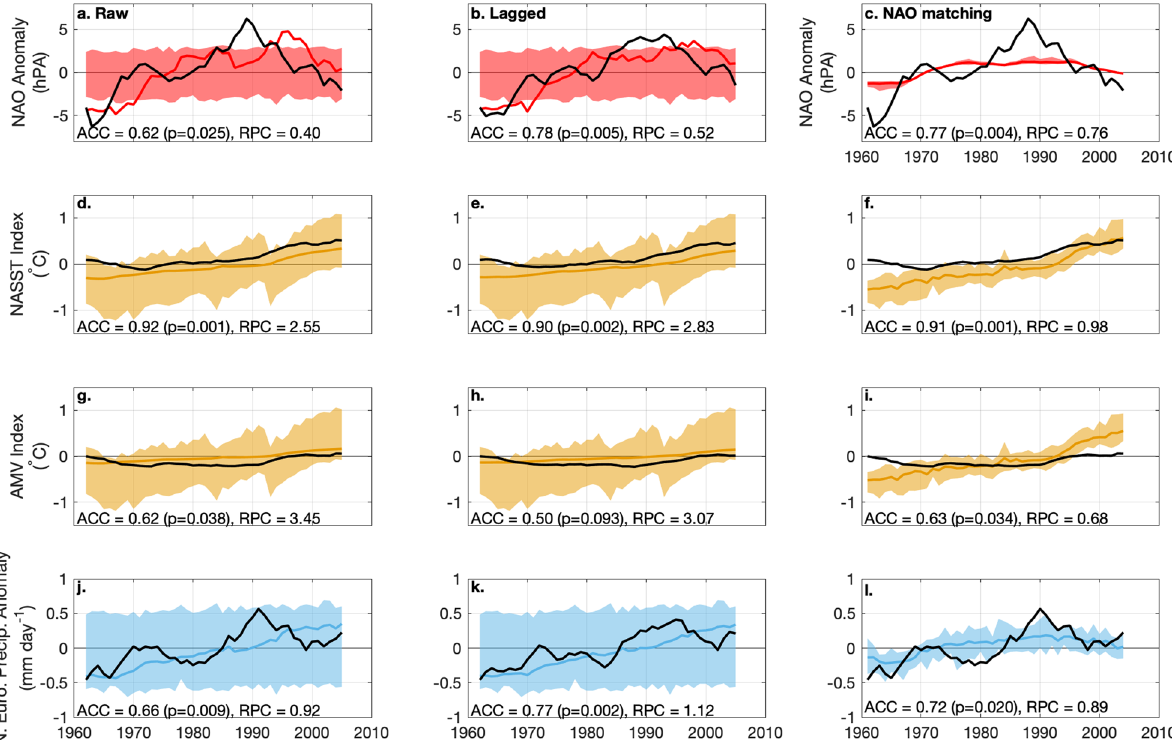
Fig. 1 Predictability from external forcing in a large multimodel uninitialized ensemble. We plot and report metrics of predictability for the NAO index ( a – c ), NASST index ( d – f ), AMO index ( g – i ), and an index of Northern European precipitation ( j – l ). We compare the three methods of calculating the ensemble mean employed by S20. First, we take the naïve average across all ensemble members in 8-year subsections and call it the “ raw ” ensemble mean ( a , d , g , and j ). Next, we augment our 8-year subsections with the prior 3 years, which we call our “ lagged ” ensemble ( b , e , h , and k ). Finally, we employ S20 ’ s NAO-matching method ( c , f , i , and l ). These approaches are described in more detail in the methods section. In each fi gure, we report the ACC along with a bootstrapped p value. The years on the x -axis re fl ect the beginning of each 8- year period, as in